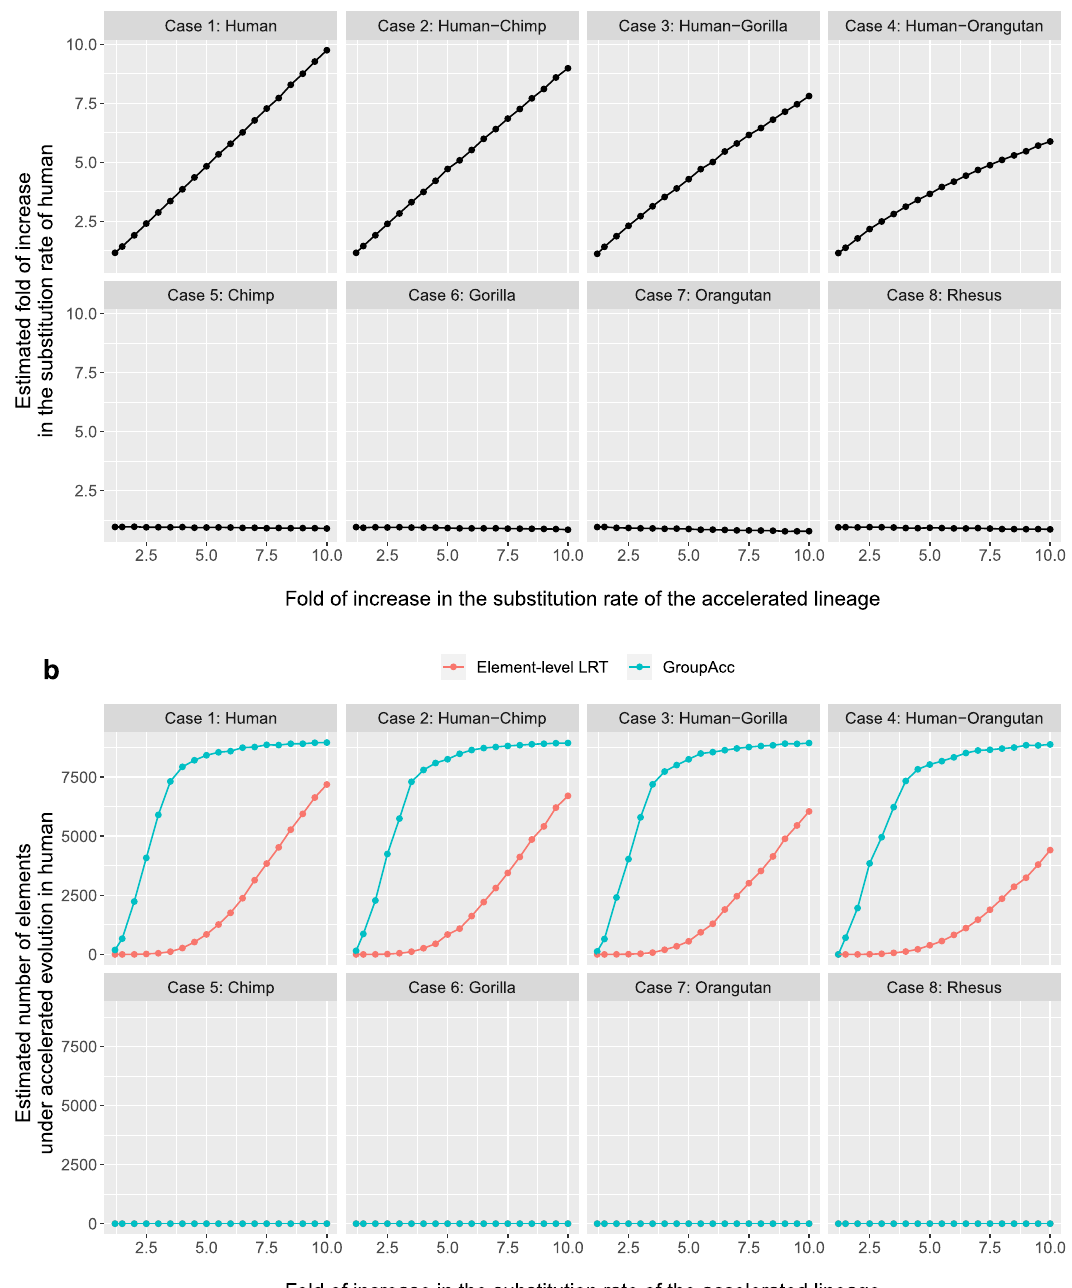
Fig.3|Simulationresultsofscenario1usinghumanasforegroundlineage.a X - axis shows the scaling factor of accelerated lineage branch length in simulation setting,whichisthe real fold of increase in the substitution rate of the accelerated lineage. Y -axis shows the fold of increase in the substitution rate of human